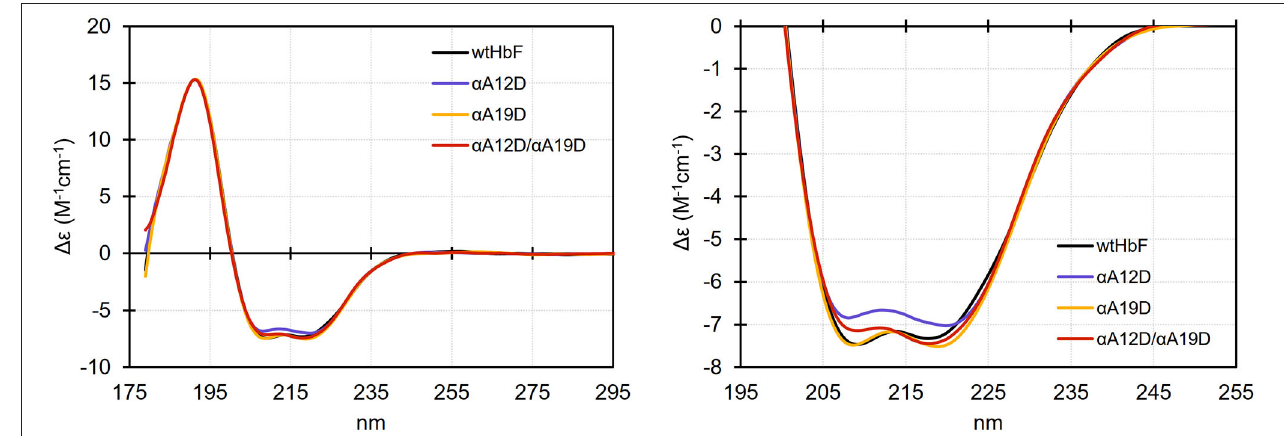
FIGURE 6 | Circular dichroism spectra (scaled at 191nm and smoothed) of wtHbF, α A12D, α A19D, and α A12D/A19D, respectively. The samples were prepared in 10mM phosphate buffer pH 6.0 and the measurements were done in a Jasco J-815 Circular Dichroism spectropolarimeter at 20 ◦ C using a 0.1mm path length cuvette. Left panel shows the full spectral range, and the right panel shows a magnified view of the spectral range covering the characteristic dual valley shape of alpha-helical